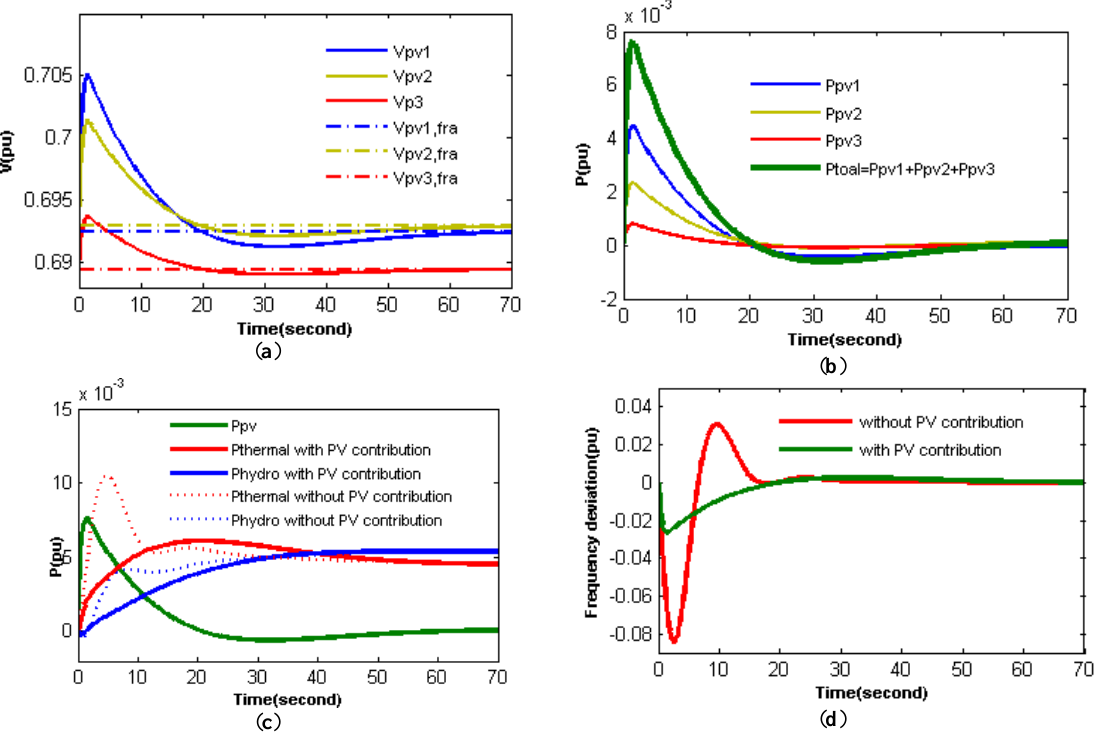
Figure 8. The response of the system in reply to a 1% rise in step load in the initial response of primary frequency control: ( a ) Voltage variation of the PV modules; ( b ) Power variation of the PV modules; ( c ) Power variation in different units; ( d ) Frequency of the System.